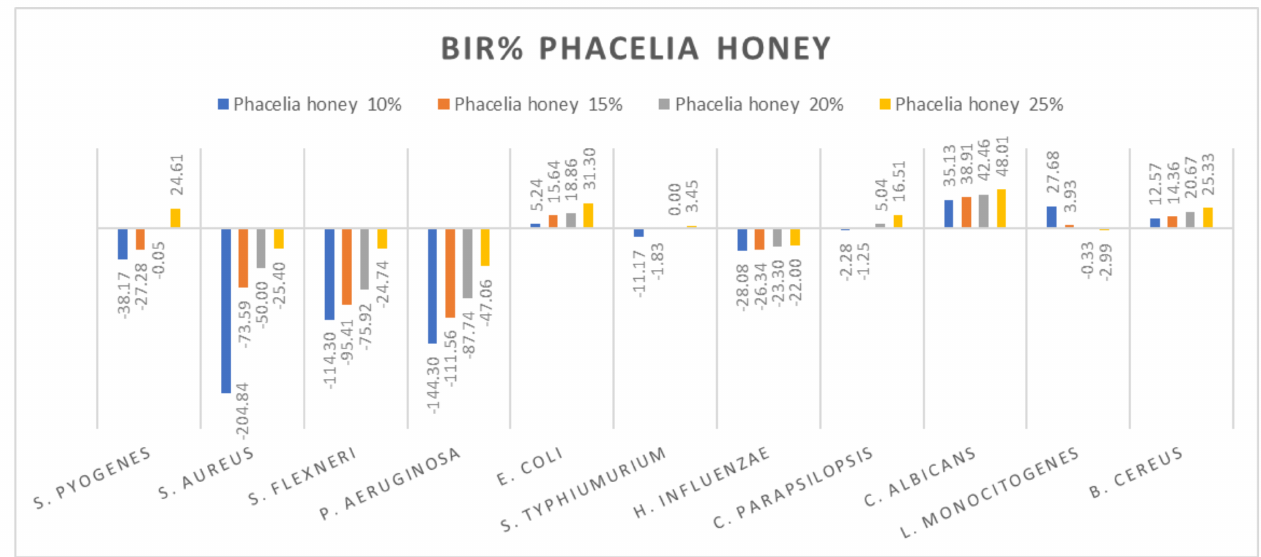
Figure 12. Phacelia honey antimicrobial activity (expressed as BIR%/MIR%) on ATCC. Hill polyfloral honey (Figure 13) showed a similar effect as wild cherry honey, the difference being made by the positive strain-boosting effect on P. aeruginosa with values ranging from − 116.75% to − 37.01% and the negative strain-boosting effect on C. albicans , with values starting at 34.62 and decreasing to 25.22. The best effect recorded for hill polyfloral honey was on E. coli (27.82%) and B. cereus (31.44%). Data recorded for plain polyfloral honey showed a different pattern. Positive inhibitory results were obtained for S. pyogenes at 25%, S. aureus at 25%, and E. coli , C. parapsilopsis , C. albicans and B. cereus, with the highest value recorded as MIR% on C. albicans (49.05). A negative boosting effect was found against S. flexneri (values ranging from − 61.33% to − 70.60%) and against S. typhimurium (from − 22.34% to − 83.65%). The quantity of honey tested influenced the inhibitory values showing a boosting effect, with MIR decreasing with the increase in concentration (Figure